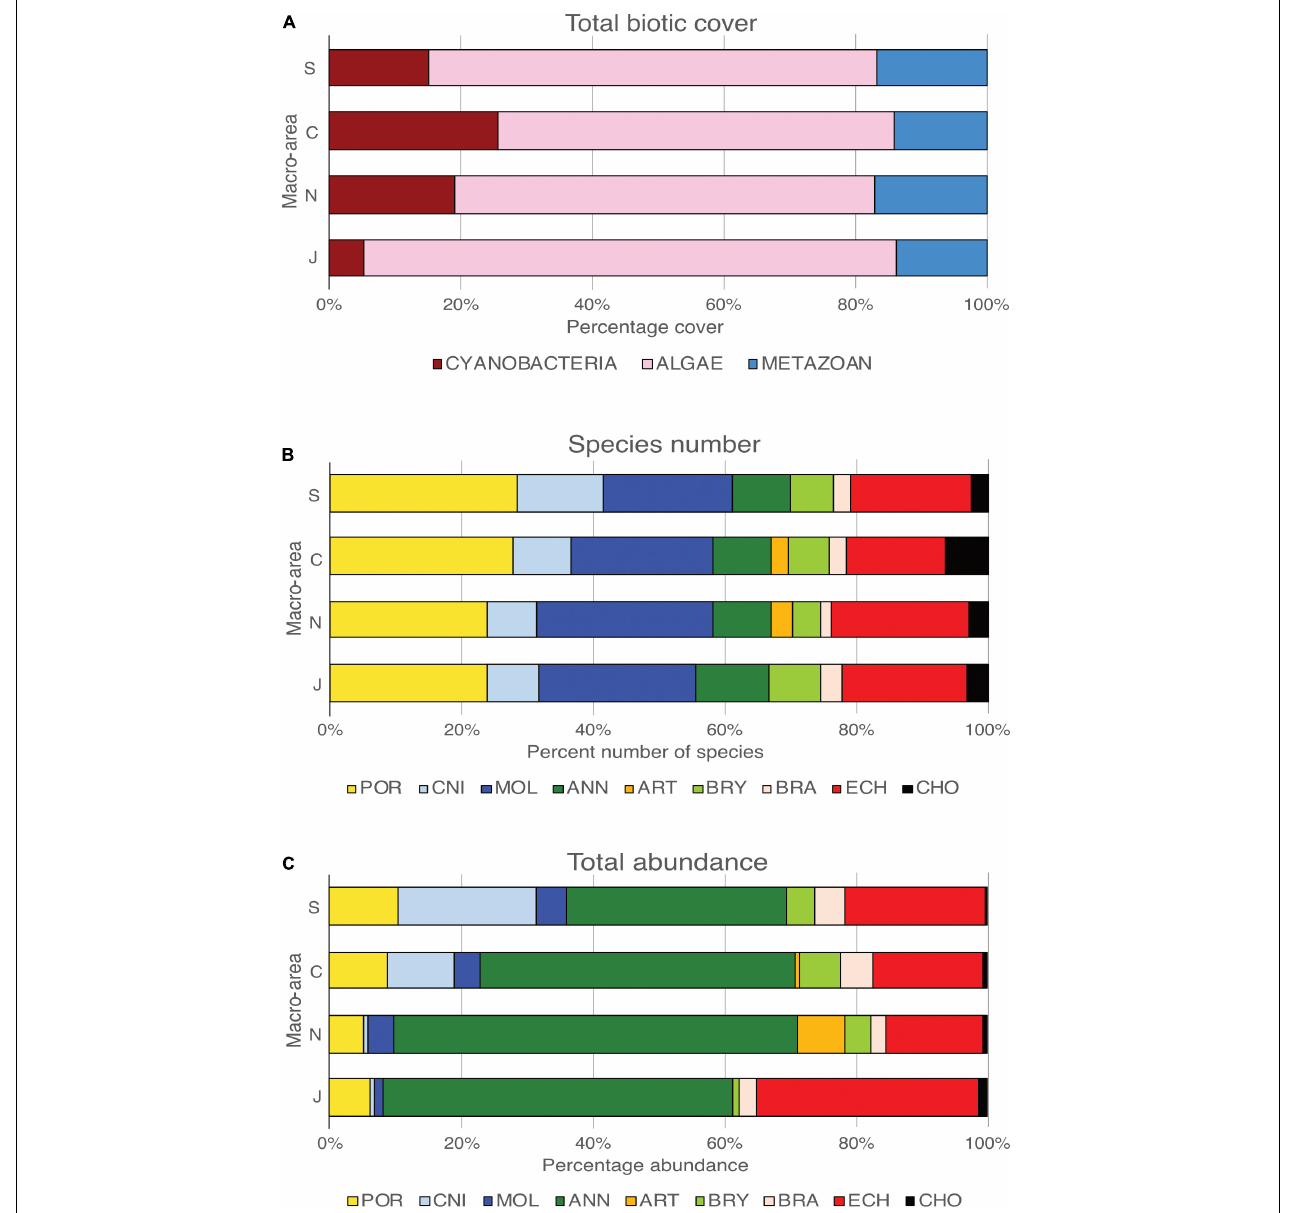
FIGURE 2 | Diversity of megafauna species along the Puyuhuapi–Jacaf fjords. Total biotic cover of Cyanobacteria, algae, and metazoans (A) , percentage of the number of species (B) , and total abundance (C) of megafauna for each phylum in each of the four